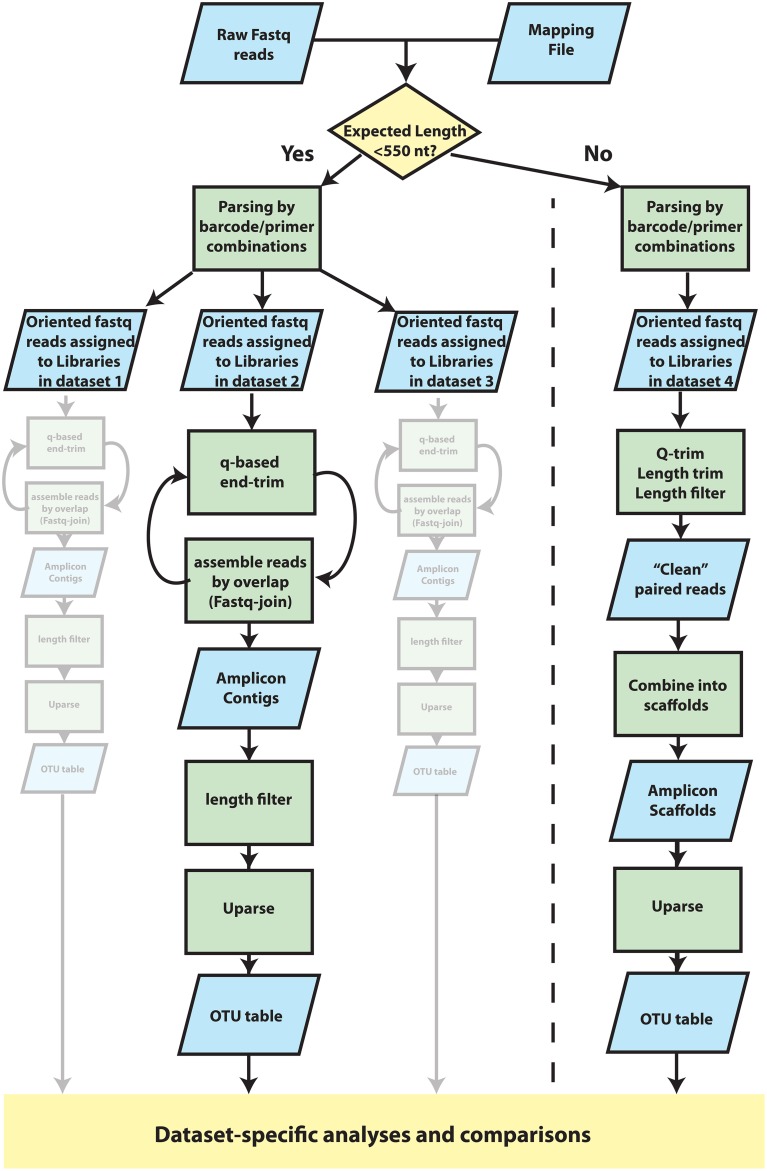
Overview of procedures that were used to cluster reads into Operational Taxonomic Units (OTUs). Detailed methods are provided in the main text. Fastq data was parsed into datasets by two analysis paths according to whether the expected amplicon length was less than or greater than 550 nucleotides in length. In both paths, reads were oriented and assigned to libraries within datasets according to a specific combination of barcode/primer. Each dataset was then filtered and processed in parallel and independently of one another. For datasets in which the expected amplicon length was less than 550 nucleotides, amplicons were assembled into contigs using an iteration between Q-score-based end-trimming and overlap-based assembly. Short contigs (<75% of expected amplicon length) were then discarded before clustering into OTUs with UPARSE. For datasets of long (>550 nt) amplicon targets, for which little if any overlap was expected, reads were instead combined into oriented, alignable scaffolds. Reads were end trimmed according to Q-score thresholds and length. Read pairs were removed if either read was less than 75% of the original read length after trimming, which resulted in individual reads with uniform length. Forward reads were then concatenated to the reverse complement of the reverse read using a small, arbitrary spacer of 4 ambiguous bases “N” and were subsequently clustered into OTUs using UPARSE. OTU tables were then used for dataset-specific analyses.